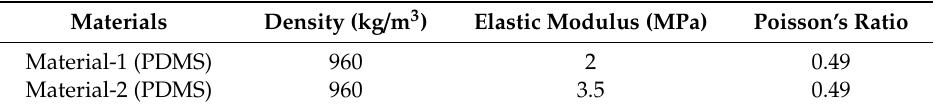
Table 1. Physical properties of PDMS.